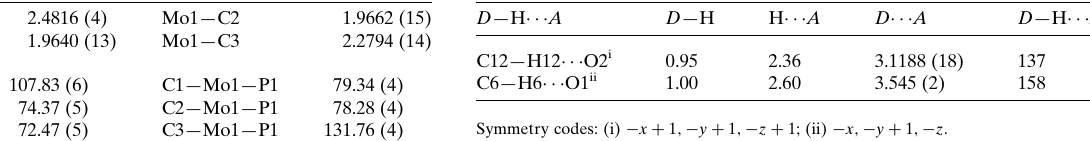
Table 1 Selected geometric parameters (A˚ , (cid:4) ) for ( 1 ).